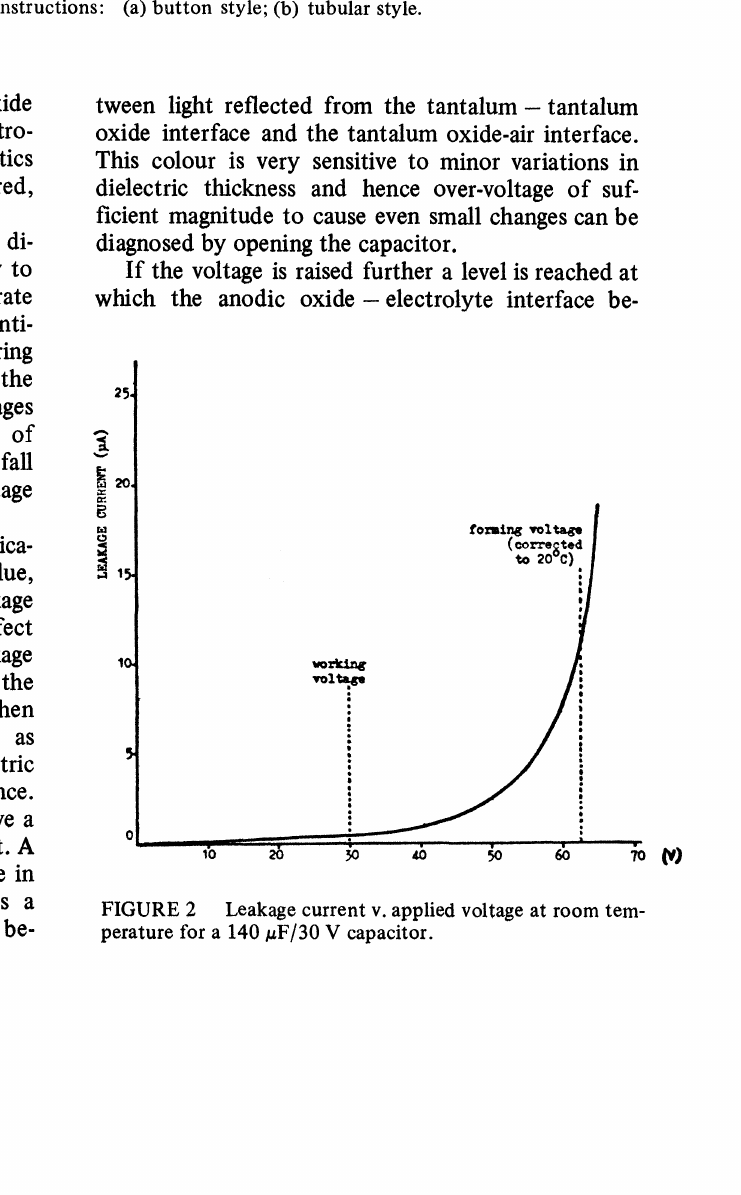
Typical capacitor constructions" (a) button style; (b) tubular style.